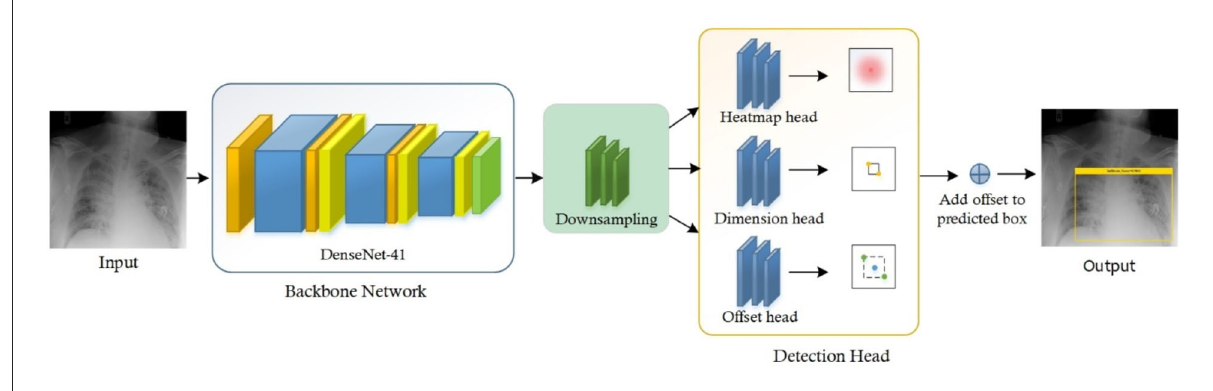
FIGURE1 Flow diagram of proposed method namely AI CenterNet